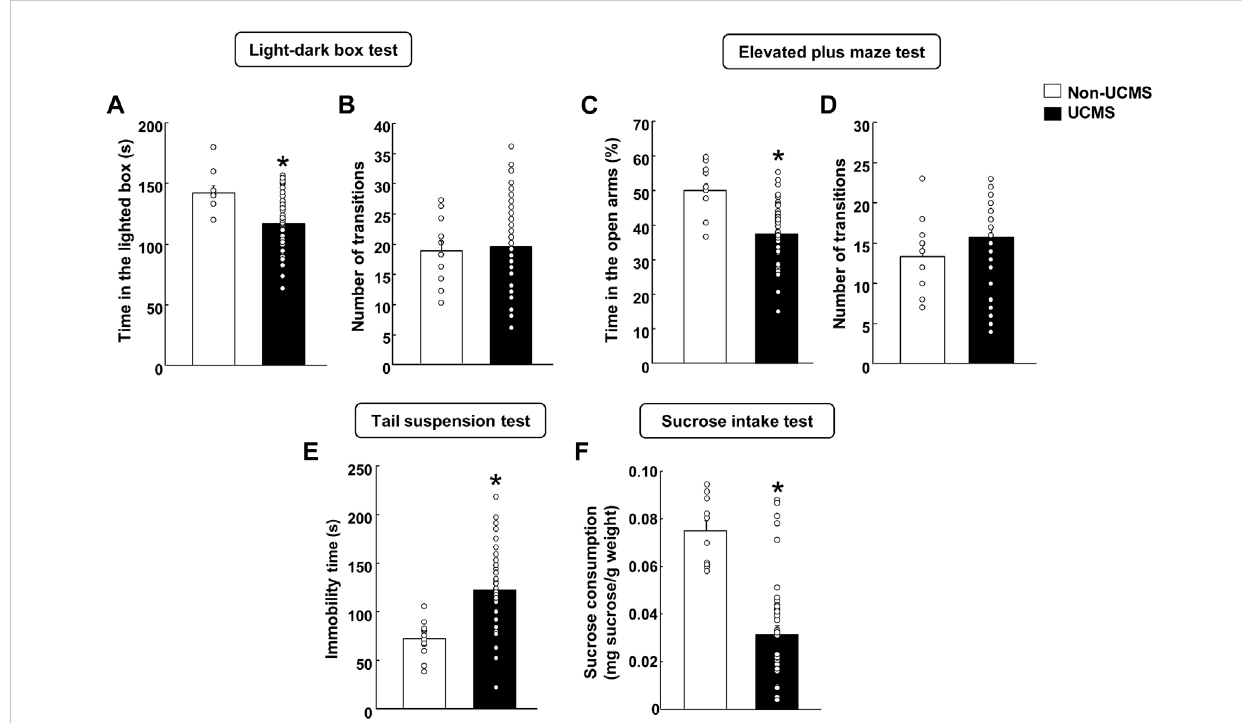
FIGURE 2 Behavioral evaluation of mice exposed to the unpredictable chronic mild stress model (UCMS) before starting pharmacological treatment . Panels (A, B) Light-dark box, Panels (C, D) Elevated plus maze, Panel (E) Tail suspension and Panel (F) Sucrose intake. Columns represent the means and verticallinesthe±SEMofeachparameterevaluated.*ValuesfromtheUCMS-exposedgroupthatdiffersigni fi cantlyfromthenon-UCMSgroup(Student ’ s t-test, p <